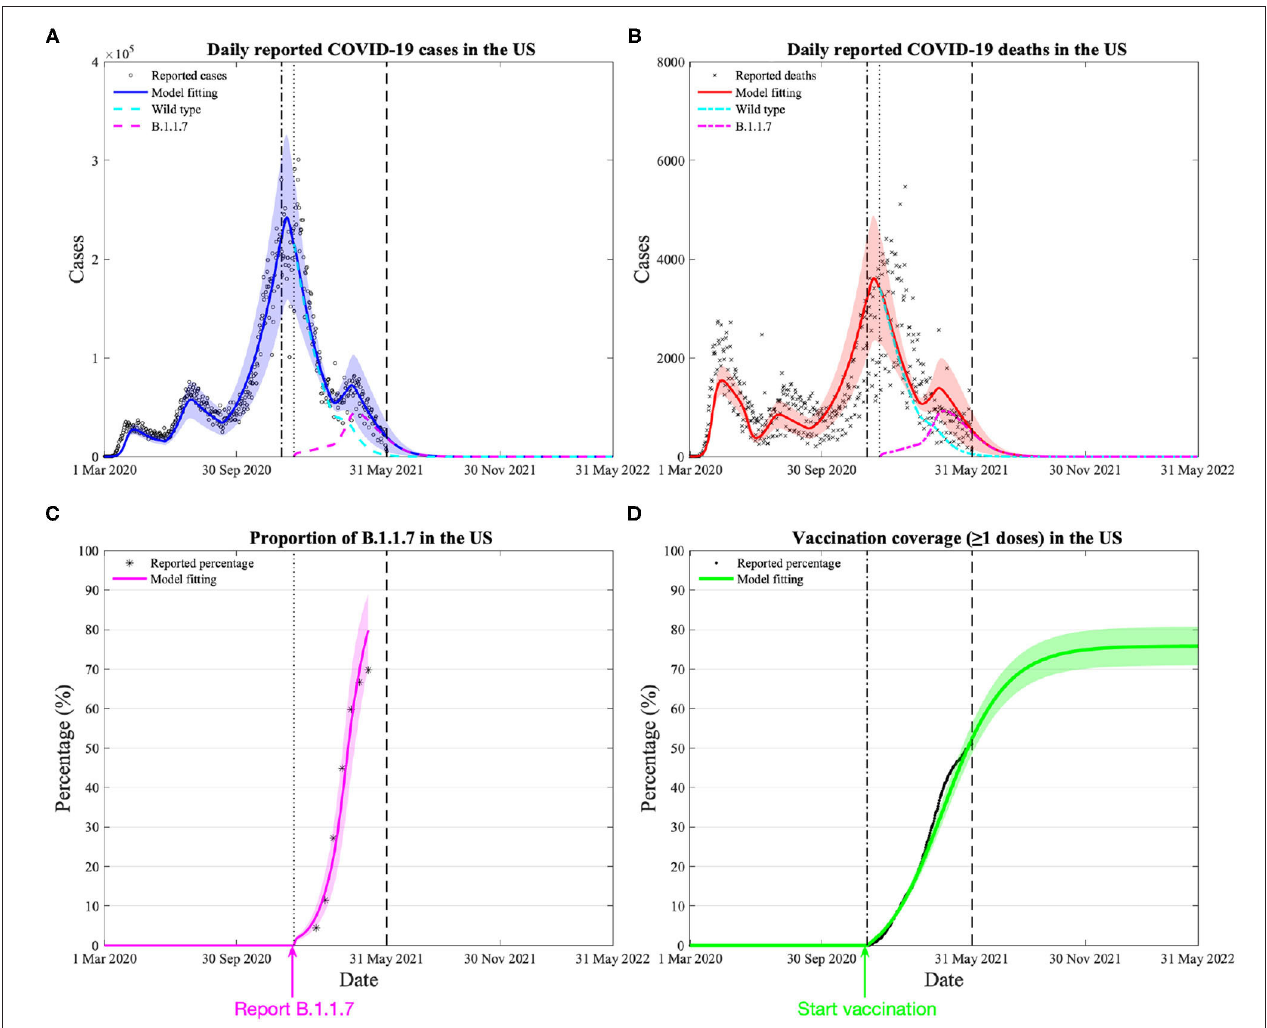
FIGURE 1 | Model calibration and estimation of vaccine effectiveness on the variant by daily COVID-19 cases, deaths, vaccination, and proportion of the dominant variant (B.1.1.7) in the US. (A) Model calibration based on 15-month daily reported COVID-19 cases in the US, the blue area denotes the 95% confidence interval, the black dash-dotted and dotted lines denote the beginning date of vaccination and reporting the variant, the green and cyan dashed lines denote the daily reported cases of wild type and the variant. (B) Model calibration based on 15-month daily reported COVID-19 deaths in the US. (C) Reported and model-fitted proportion of the variant (of all reported cases) in the US. (D) Reported and model-fitted vaccination coverage ( ≥ 1 doses) in the